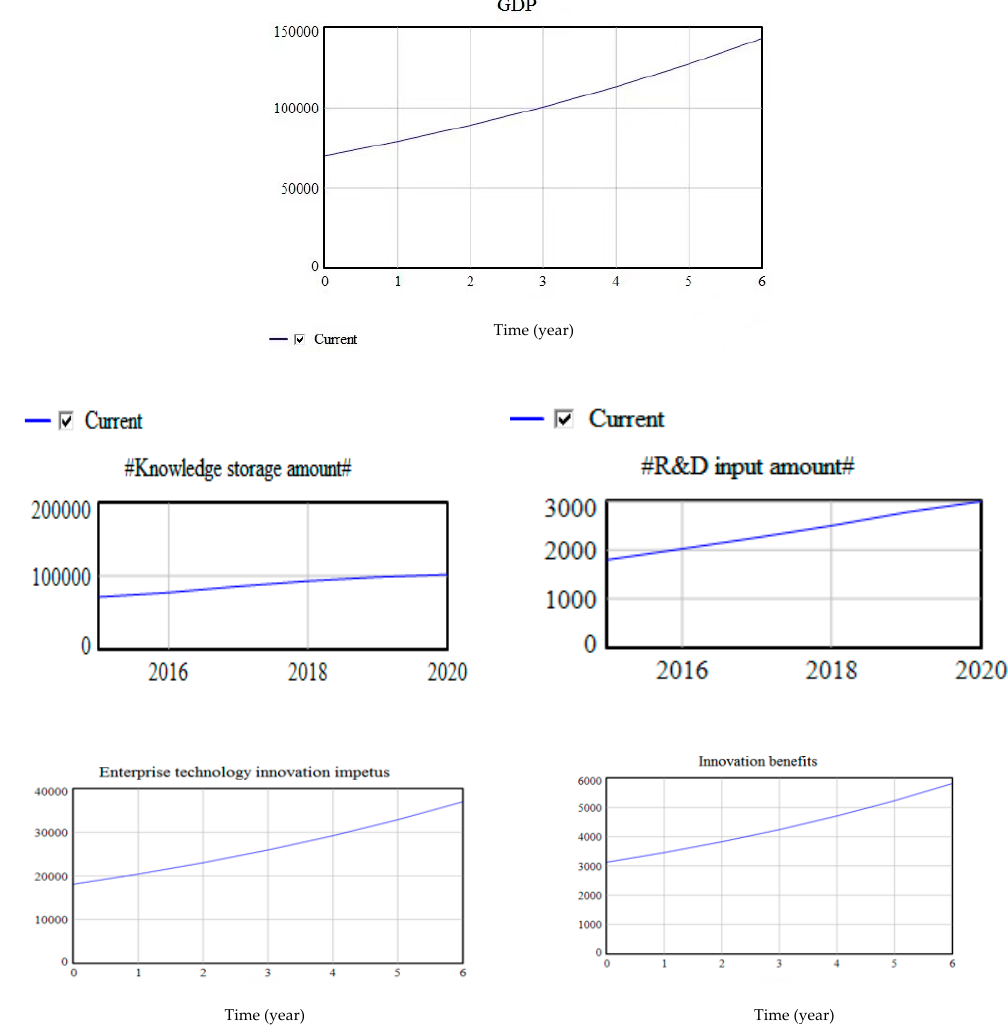
Figure 2. Regional gross output value and simulation group diagram of the main factors. (Note: In the above Figure 2, the horizontal axis represents the year, and the vertical axis represents the quan- tity).